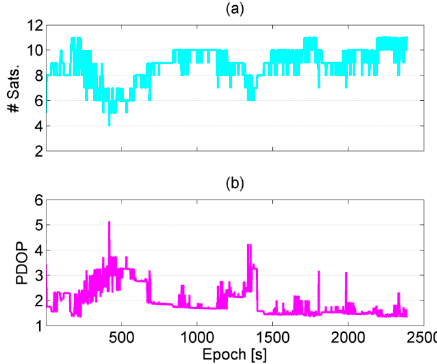
Figure 15. ( a ) Satellite numbers; and ( b ) PDOP values. The data are calculated from dataset no. 3.